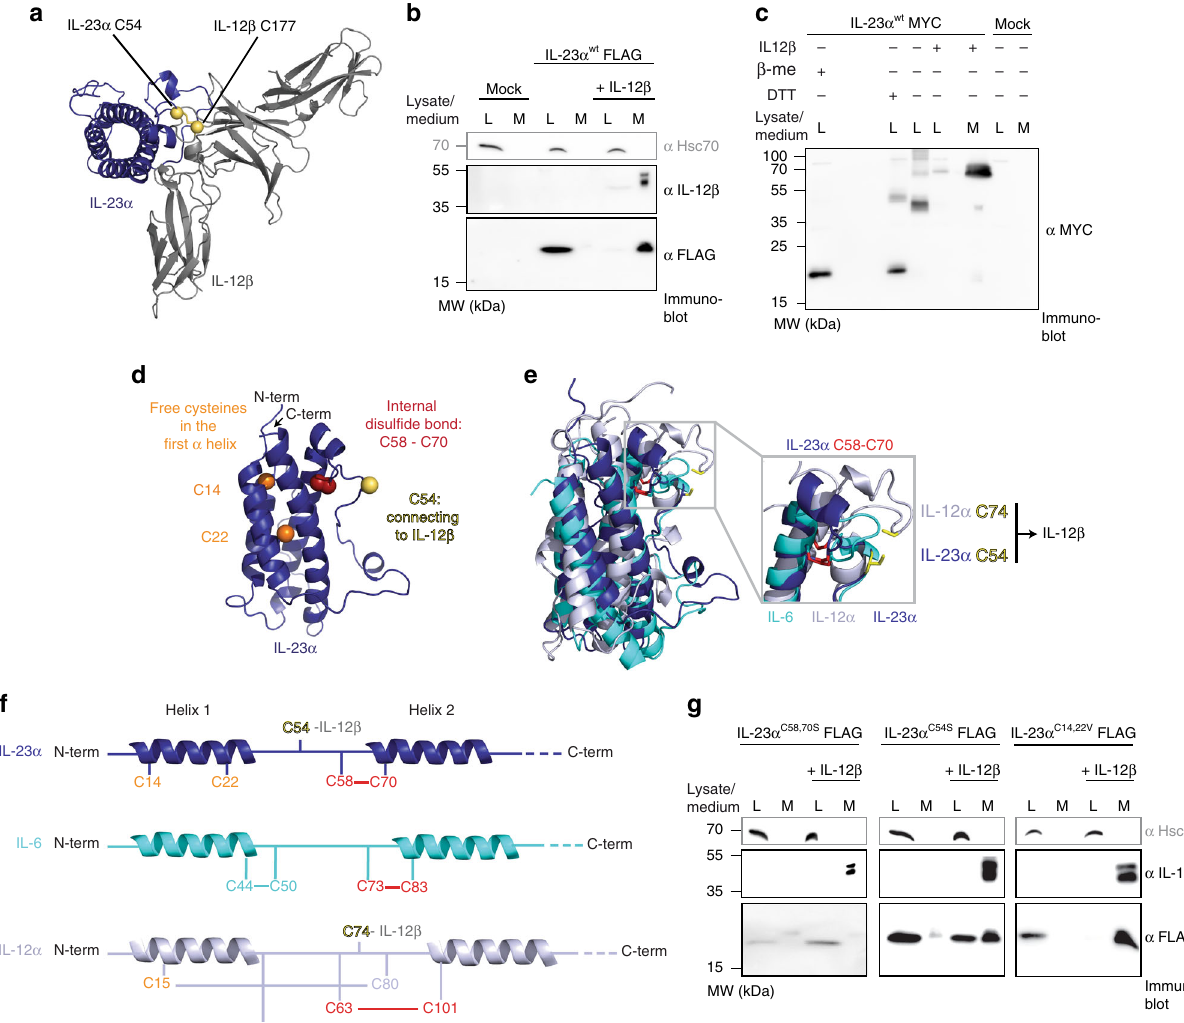
Fig. 1 IL-23 α misfolds in cells in the absence of IL-12 β . a Structure of heterodimeric IL-23. Cysteines in IL-23 α (blue) and IL-12 β (gray) that form an intermolecular disul fi de bond are shown in yellow. b Secretion behavior of FLAG-tagged wild type IL-23 α (IL-23 α wt ) in the presence or absence of its interaction partner IL-12 β . Hsc70 served as loading control. c IL-23 α forms non-native disul fi de bonds in isolation (lane 3) and IL-12 β covalently heterodimerizes with IL-23 α (lanes 4 and 5), concomitantly reducing misfolding of IL-23 α . Samples were treated with β -Me post-lysis/DTT in cells for reduction where indicated and with NEM to conserve redox species. d Structure of IL-23 α . Cysteines that form an intramolecular disul fi de bond in IL-23 α are shown in red, the one that engages with IL-12 β is highlighted in yellow, and free cysteines are depicted in orange. e Structural alignment of IL-23 α (blue), IL-6 (cyan) and IL-12 α (light gray). The conserved disul fi de bond is shown in red and the IL-12 β engaging free cysteines of IL-23 α and IL-12 α in yellow. f Model of IL-23 α , IL-6 and IL-12 α illustrating cysteines and disul fi de bonds. The same color code as in d, e was used. Numbering is without signal sequences. g Secretion behavior of FLAG-tagged IL-23 α constructs as in b but with the indicated IL-23 α cysteine